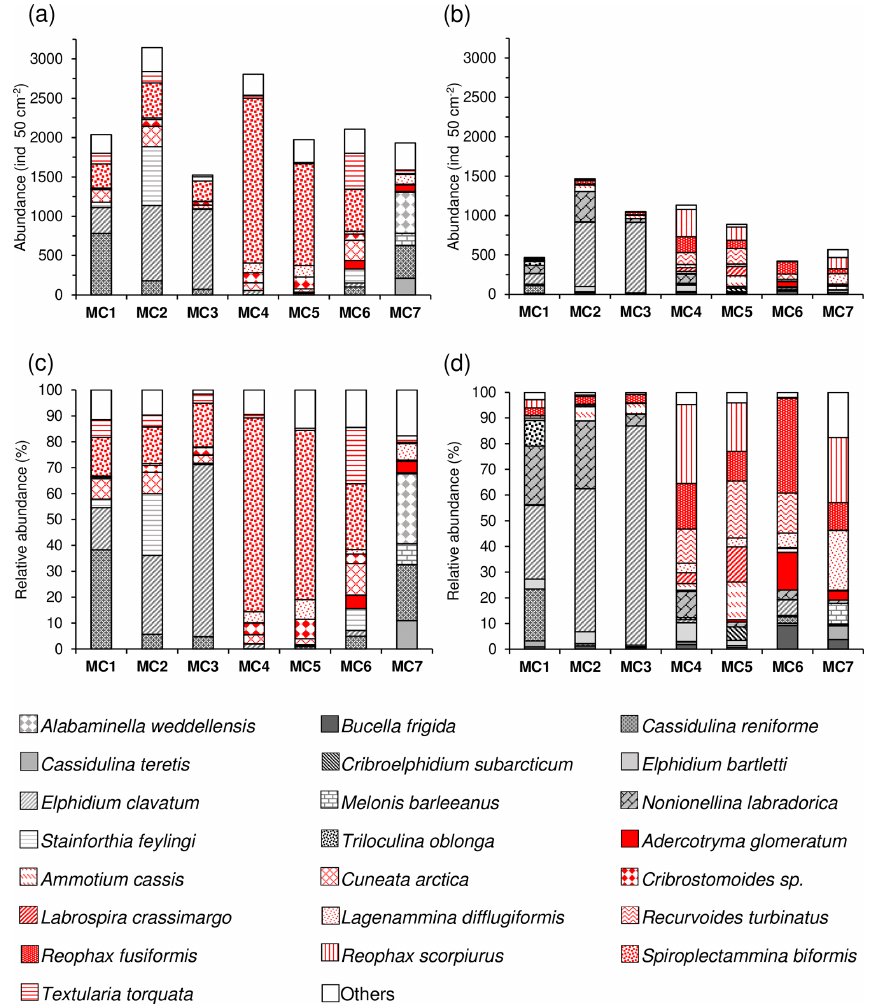
Figure 7. Total abundances (ind. 50cm − 2 ) and correspondent relative abundances (%) of the dominant species ( > 5% for at least one station) of the 0–1cm sediment layer for the 63–150µm fraction (a, c) and the > 150µm fraction (b, d) . The calcareous species are shown using different grey textures, whereas agglutinated species are shown using different red textures.